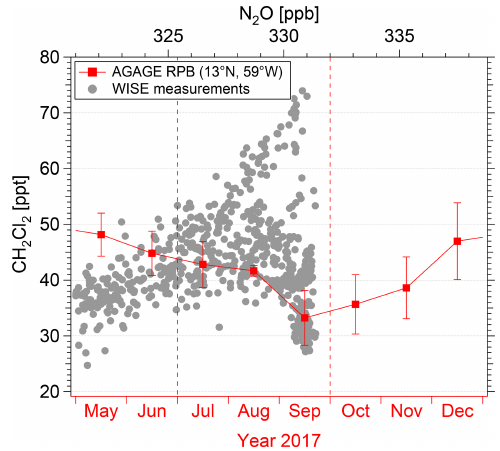
Figure 3. CH 2 Cl 2 –N 2 O relationship color coded by flight date. The inset shows a detailed magnification of decreasing CH 2 Cl 2 mixing ratios with increasing N 2 O within the lower branch of the CH 2 Cl 2 –N 2 O relationship. Air parcels below the thermal tropopause are marked as open circles and air parcels above by closed circles.